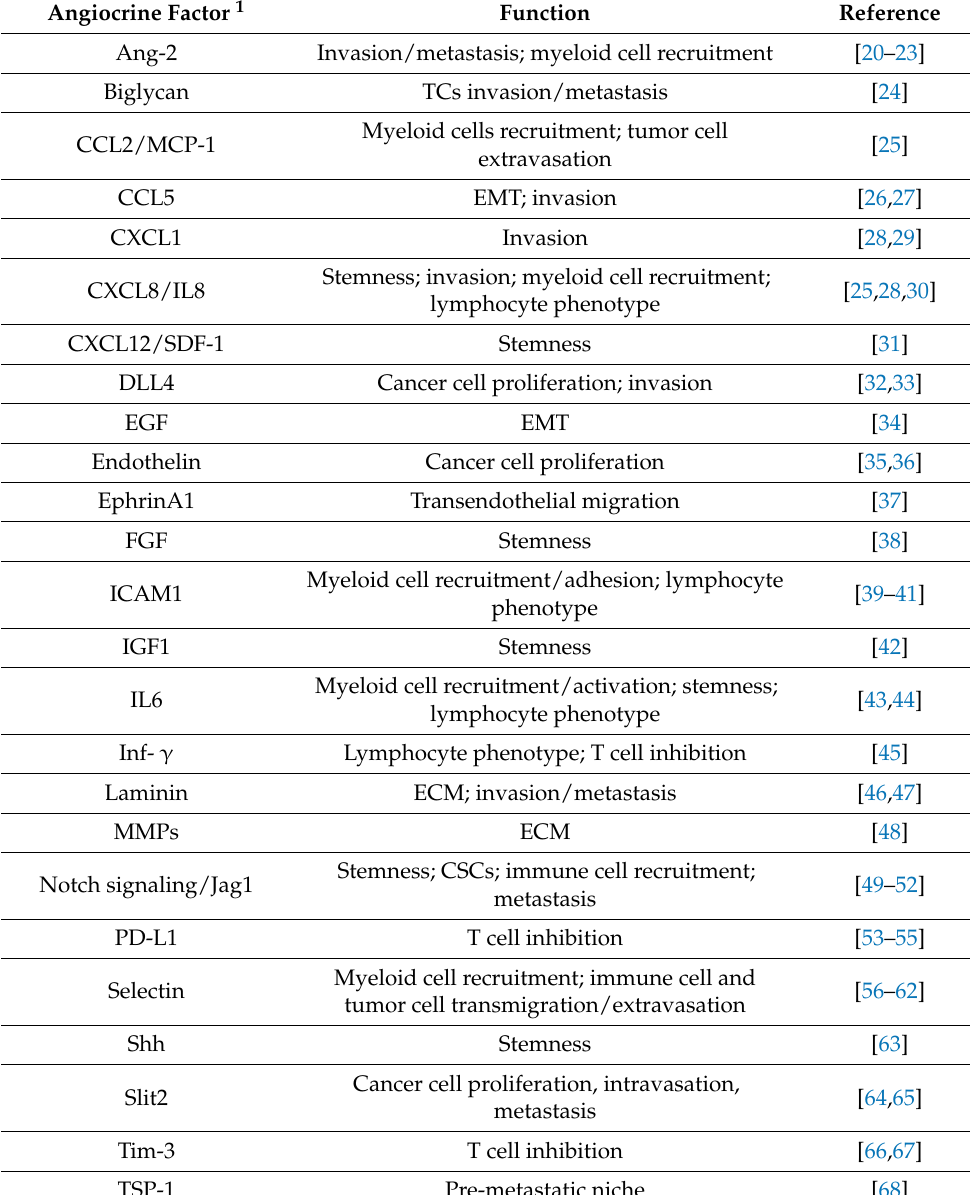
adhesion proteins, like intercellular adhesion molecule 1 (ICAM1), vascular cell adhesion molecule 1 (VCAM1), E-selectin and P-selectin, which are involved in the recruitment of leukocytes but also in the transmigration of cancer cells across the vessel wall; and (ii) chemokines, like interleukin-8 (IL-8 also known as CXCL8), monocyte chemotactic protein 1 (MCP1; also known as CCL2), stromal cell-derived factor 1 (SDF1; also known as CXCL12) and other factors which influence the recruitment and polarization of immune cells [3,6]. Table 1. List of tumor-induced angiocrine factors and their described